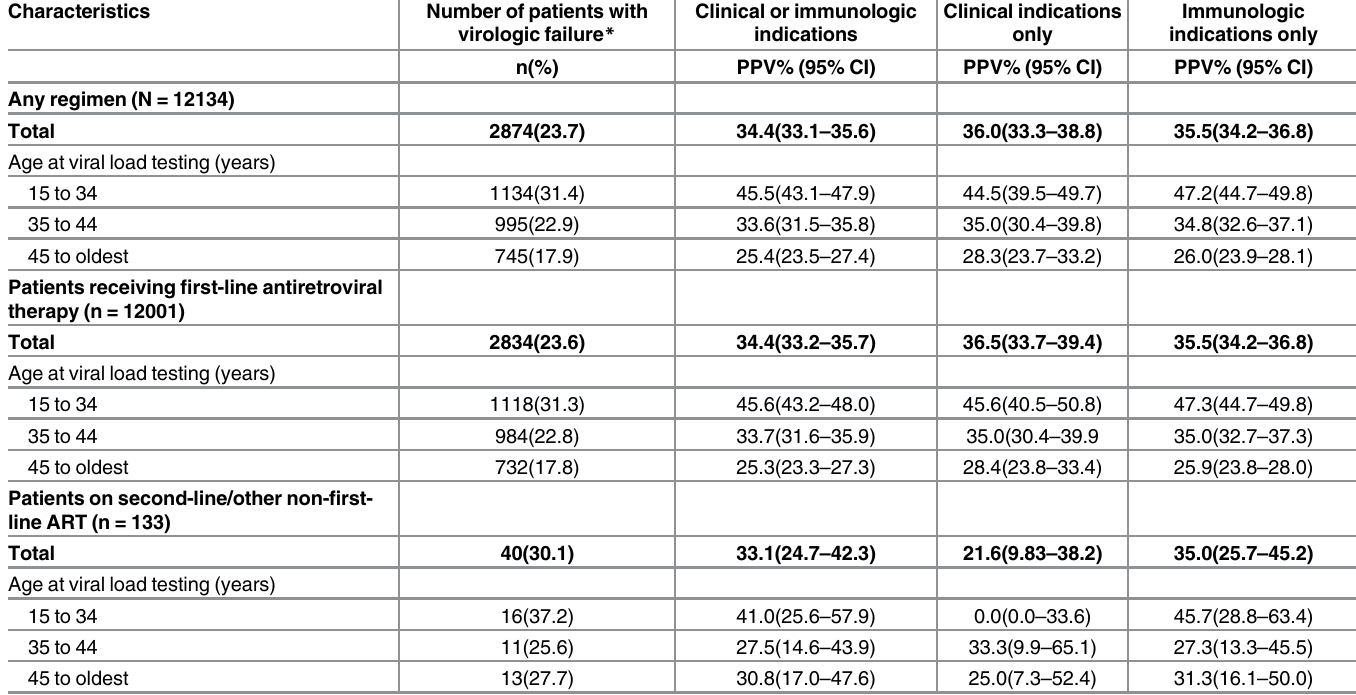
Table 3. Positive predictive value (PPV) of clinical and immunologic criteria for identifying treatment failure among HIV-infected adults receiving first-line or second-line/other antiretroviral therapy, Nyanza Province, 2008 –